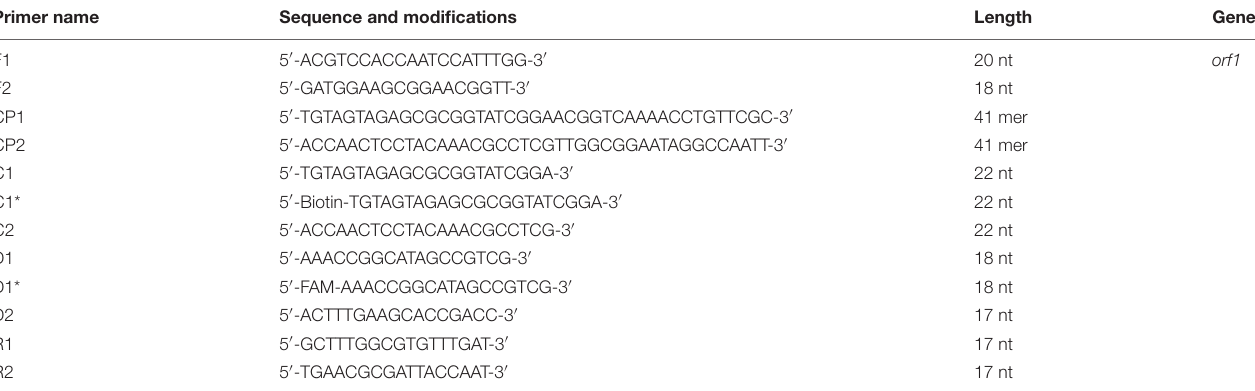
TABLE 1 | Neisseria gonorrhoeae -multiple cross displacement amplification (MCDA) primers used in this study. Primer name